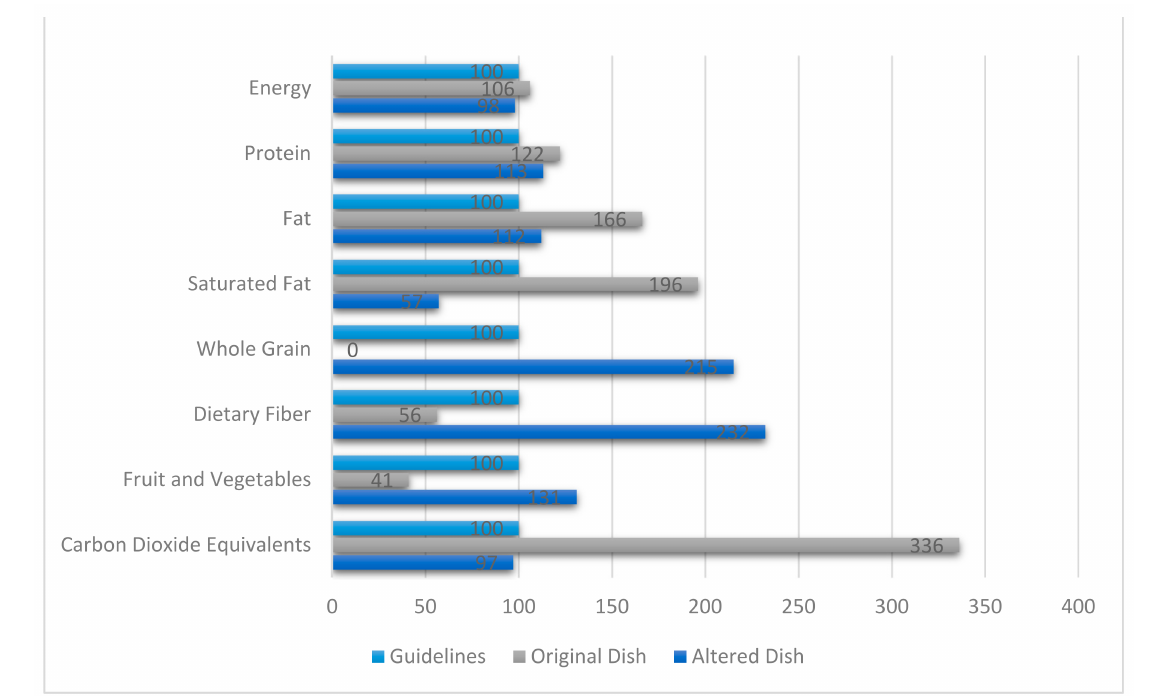
Figure 3. Average nutritional content and climate impact (kilogram CO 2 e) of the original and altered food dishes per portion in comparison with the Nordic Nutrition Recommendations [40], the Swedish Food Agency [41,42] and the climate impact goals set by WWF [44]. The x-axis values are defined in percent relative to the guidelines presented in Tables 1 and